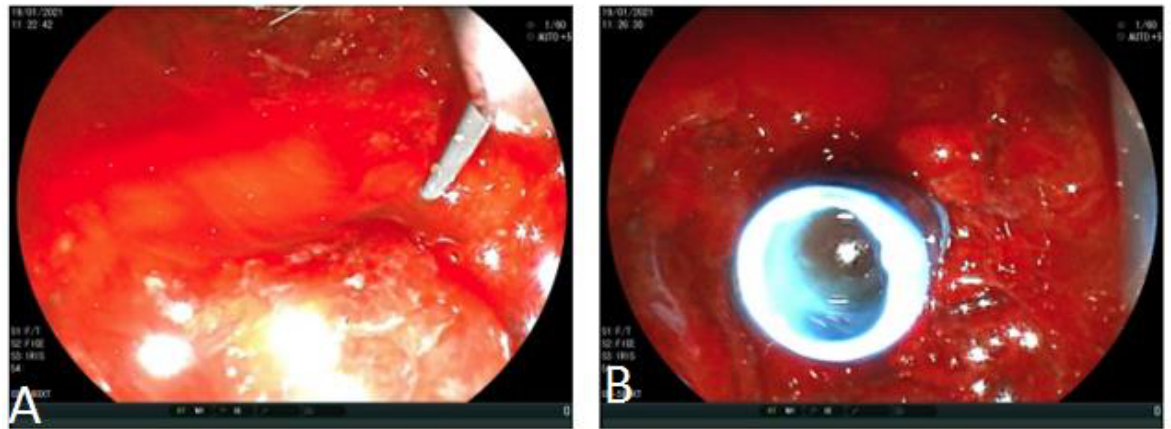
Figure 9. ERCP ( A , B ). insertion of a plasticbiliary prosthesis 9 cm 10 Fr through metallic duodenal mesh with resolution of obstruction.